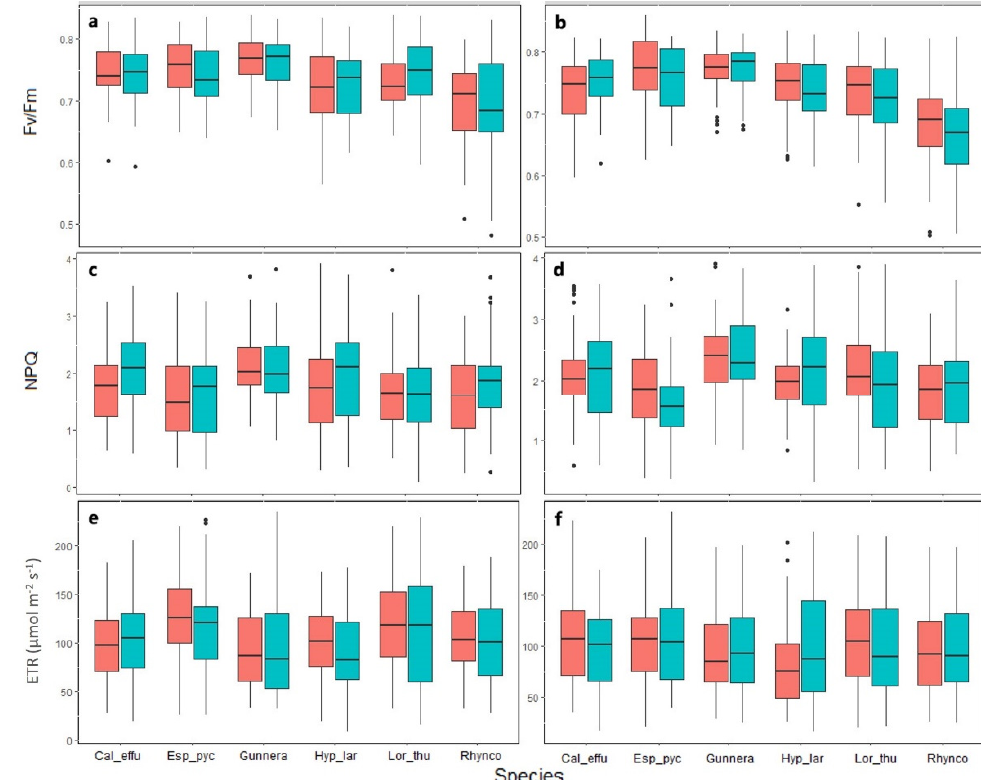
Figure 2. Chlorophyll a fluorescence parameters in páramo plants in two study areas. Conserved area ( left ) and intervened area ( right ), subjected to passive warming in the OTC treatment (red) and control without OTC (blue). Pooled data for all seasons, n = 58, p > 0.05. Cal_effu = Calamagrostis effusa , Esp_pyc = Espeletia pycnophylla , Gunnera = Gunnera magellanica , Hyp_lar = Hypericum laricifolium , Lor_thu = Loricaria thuyoides , Rhynco = Rhynchospora macrochaeta . Fv/Fm Maximum quantum efficiency of photosystem II ( a , b ), NPQ non-photochemical quenching ( c , d ), and ETR Electron transport rate ( e , f ). The black points are